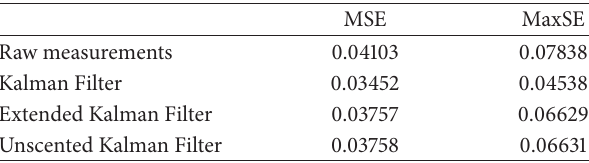
Table 2: Linear path results.